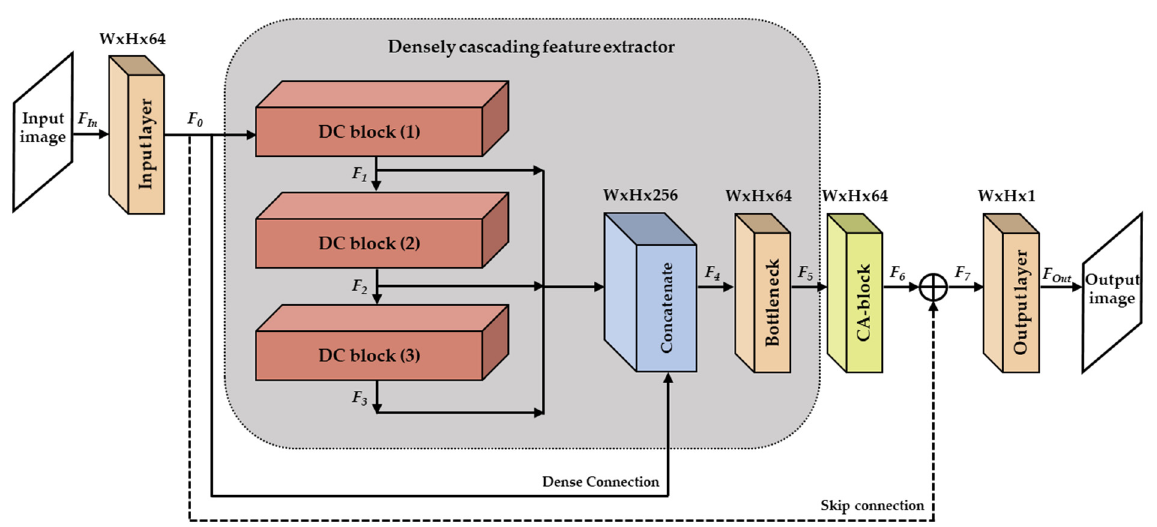
Figure 1. Overall architecture of the proposed DCRN. Symbol ‘+’ indicates the element-wise sum.